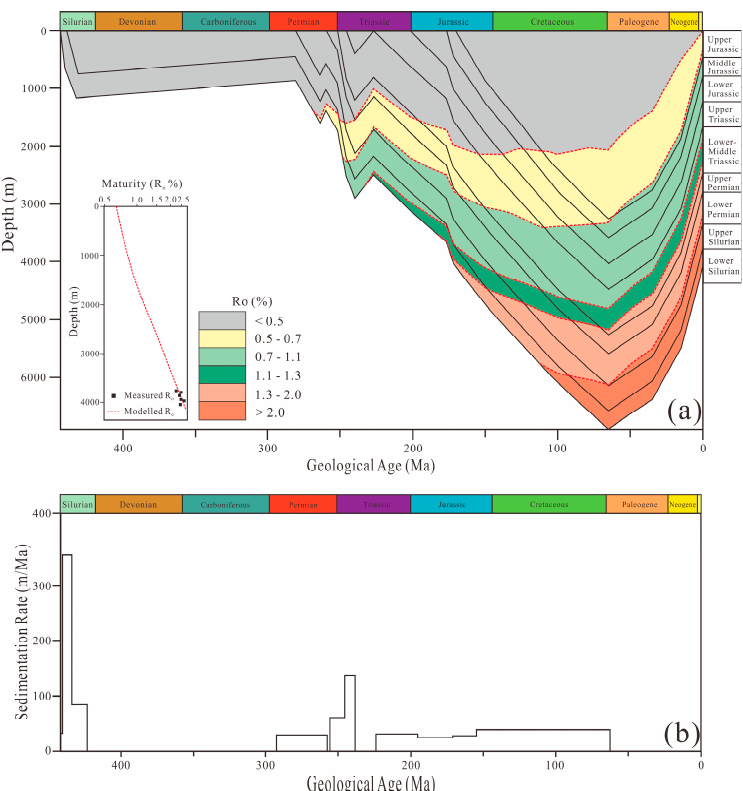
Figure 4. Modeling and calibration results. ( a ) The burial, thermal, and maturity evolution history of Well H-2; ( b ) Sedimentation rate of Well H-2, showing more than 354 m/Ma and 135 m/Ma in the late Silurian and Early Triassic rapid subsidence periods, respectively.